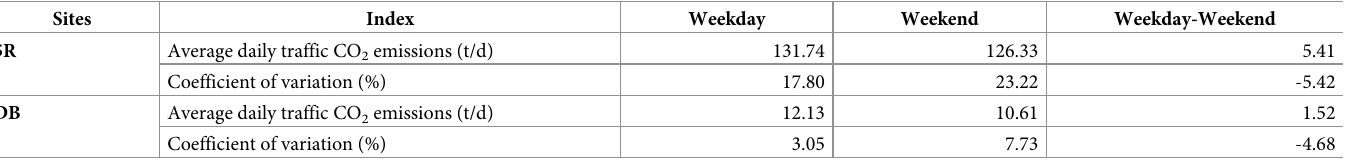
Table 1. Comparative analysis of traffic CO 2 emissions of weekdays and weekends between 5R and DB.